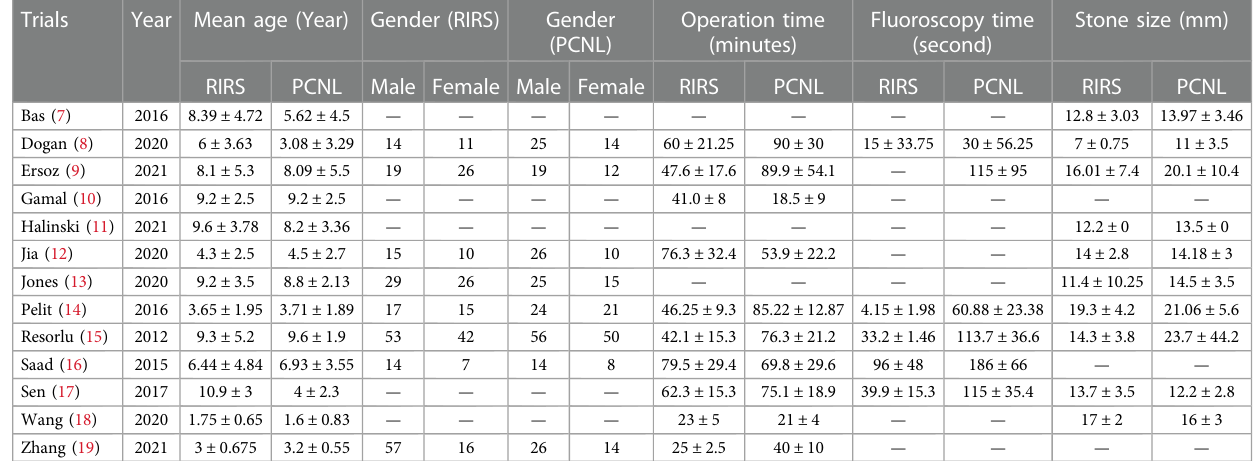
TABLE 2 Clinical characteristics of included studies.